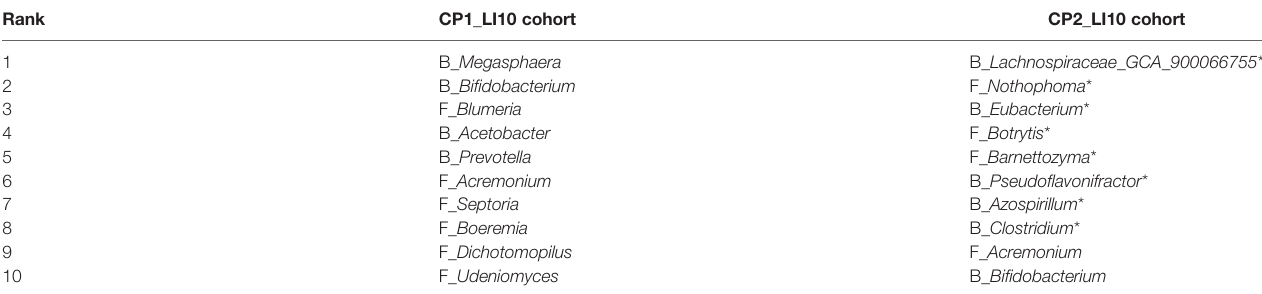
TABLE 2 | The top 10 microbes with most correlations in the intestinal microbiome networks of the LI10 cohorts with different cytokine pro fi les, i.e., CP1_LI10 and CP2_LI10 cohorts.